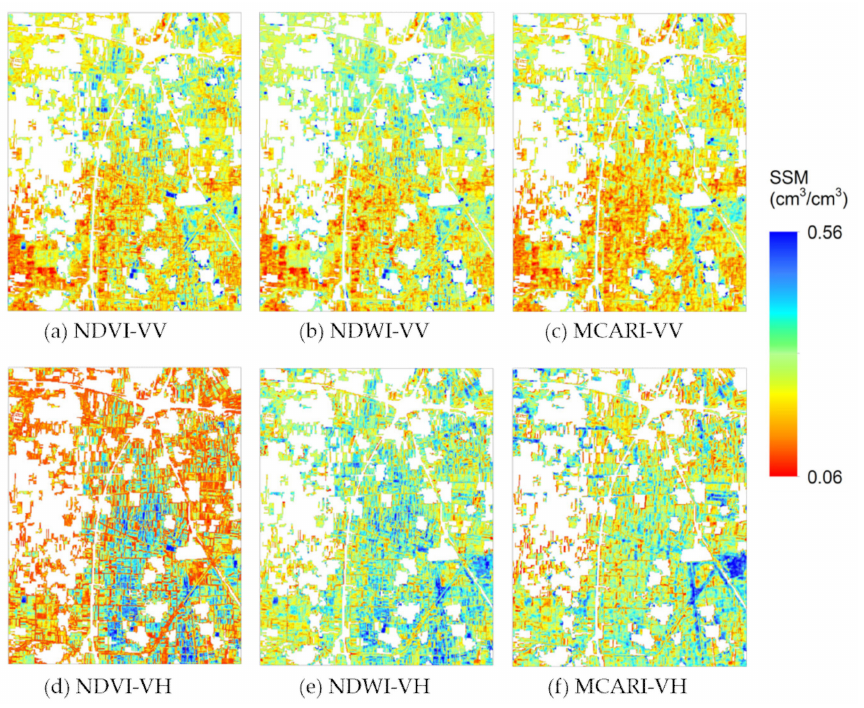
Figure 5. SSM mapping in a sample in Gu’an, Hebei.